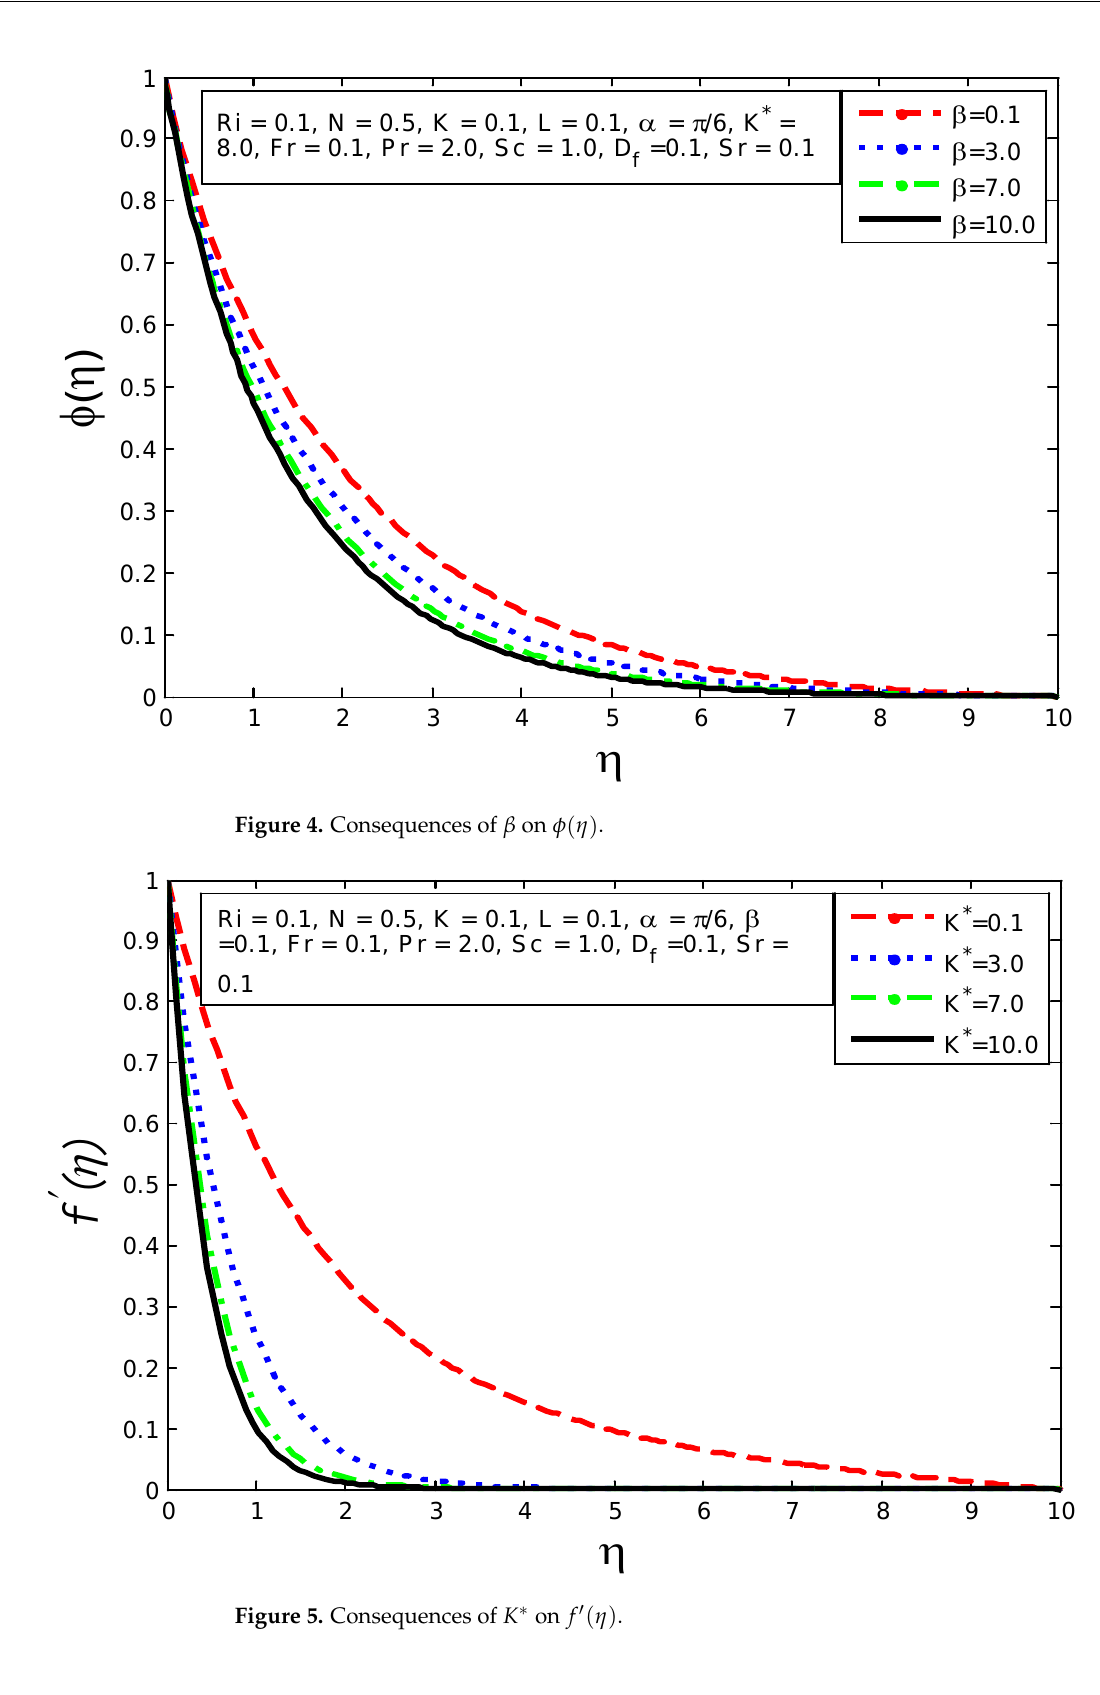
Figure 3. Consequences of